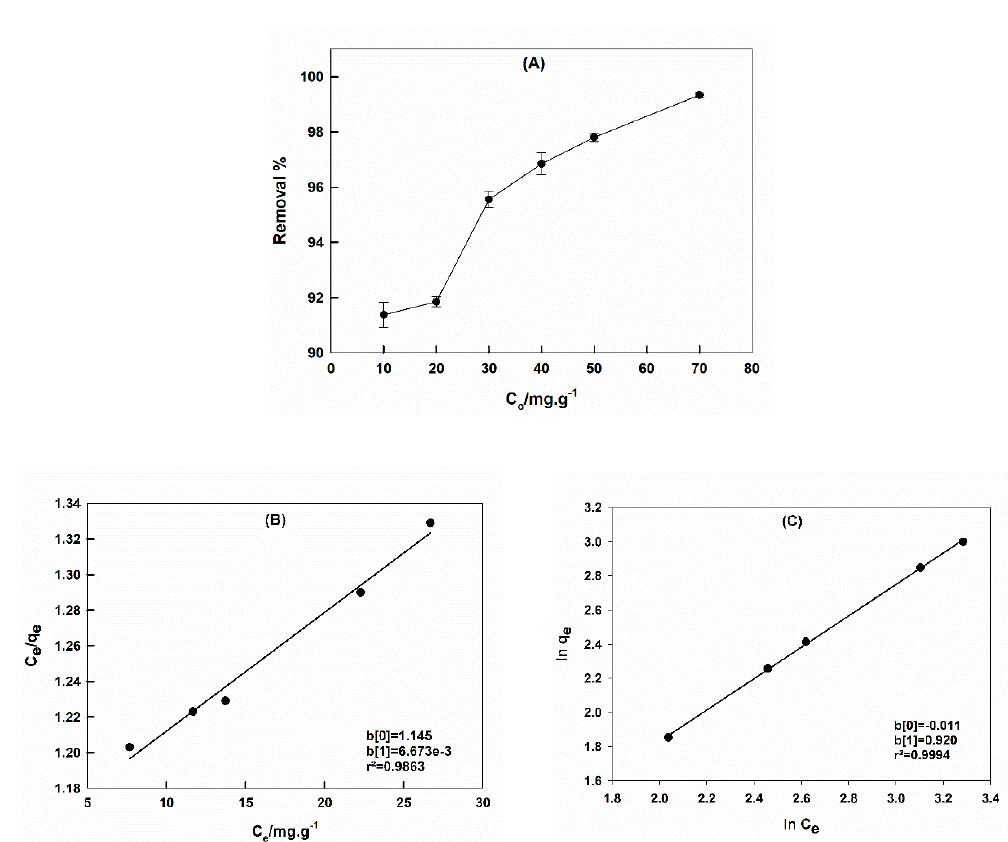
Figure 6. The relation between the CR removal by CTAB-capped La 0.9 Sr 0.1 FeO 3 and the initial CR concentration; pH = 6, contact time = 1 h, at 25 ◦ C ( A ). Langmuir ( B ) and ( C ) Freundlich concentration; pH = 6, contact time = 1 h, at 25 ° C (A). Langmuir (B) and (C) Freundlich isotherms.